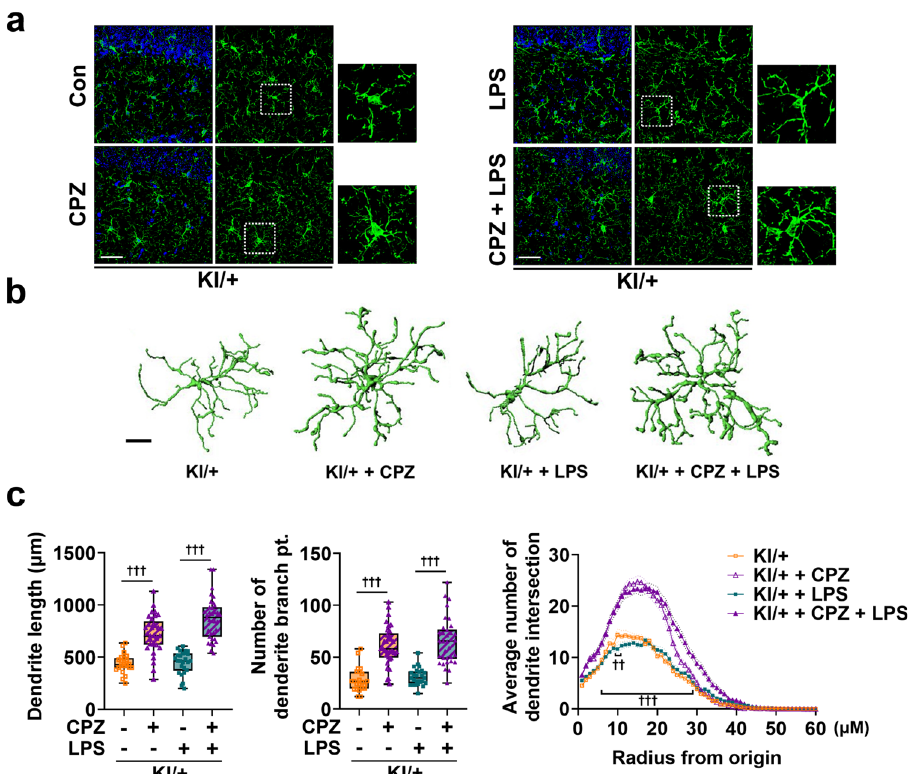
Fig. 9 Chlorpromazine recovers microglial morphology. a Representative immuno fl uorescent images by IBA-1 staining in the hippocampus of WT and KI/ + mice (8-week-old, male, n = 4 mice with similar results). Insets, 2.5-fold enlarged images. Scale bar, 25 μ m. b Representative 3D fi lament tracking images of IBA-1 signals generated by IMARIS software. Scale bar, 10 μ m. c Dendrite length, number of branching branch points, and Sholl radius analysis. Data extracted from FilamentTracker in IMARIS analysis ( n > 22 cells per group from four mice) (KI/ + vs CPZ-injected KI/ + : ††† p < 0.0001; LPS-injected KI/ + vs LPS and CPZ-injected KI/ + : ††† p < 0.0001; one-way ANOVA; radius 10 μ m, KI/ + vs LPS-injected KI/ + : †† p = 0.0049; radius 6 – 29 μ m, LPS- injected KI/ + vs LPS and CPZ-injected KI/ + : ††† p < 0.0001; two-way ANOVA). The bounds of the box represent 25th to 75th percentiles ranges. The center lines with the box represent the mean value and whiskers represent the minimum to the maximum range. Data are mean ± SEM. †† p < 0.01, and †††